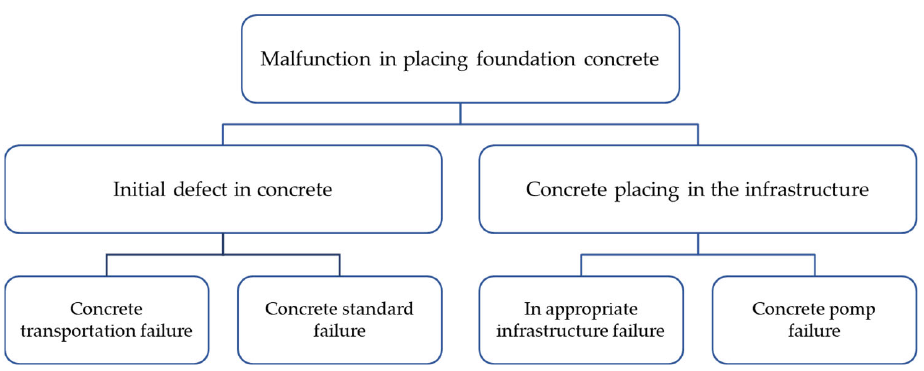
Figure 3. Work breakdown structure of a building construction project.